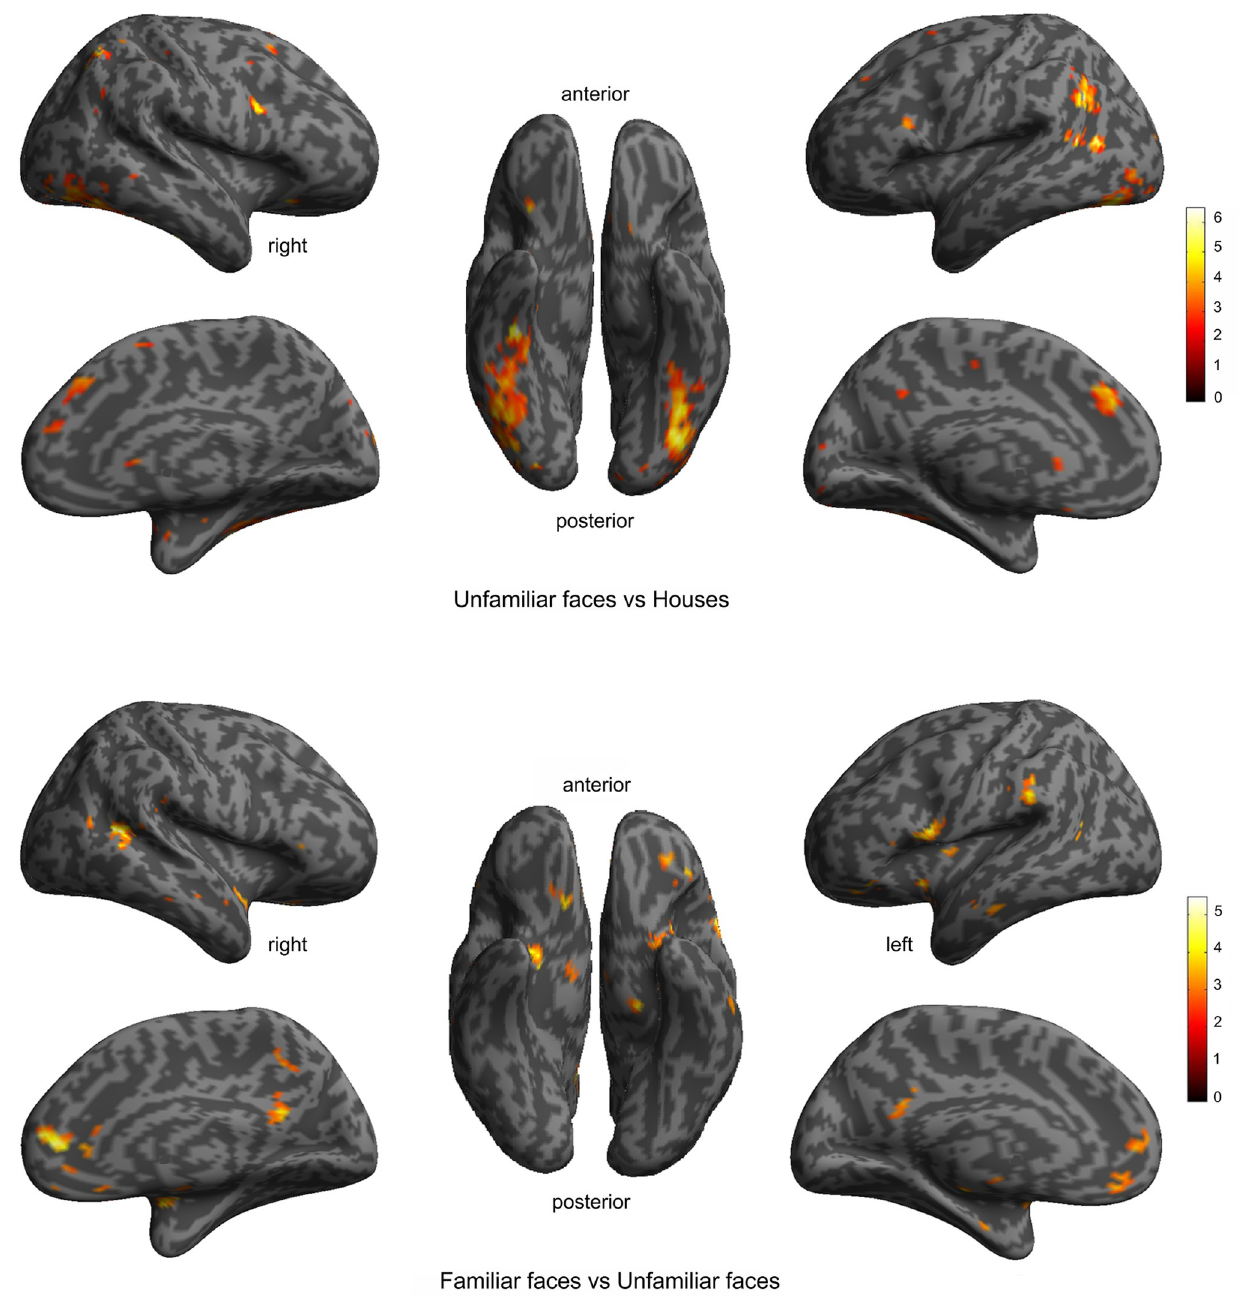
Fig 1. Functional activation identified by the contrasts: A) faces > houses and B) familiar faces > unknown faces. Maps were overlaid on the average inflated cortical surface of the SPM. The figure depicts voxels surviving p < 0.001 and p < 0.01 uncorrected, respectively. Color indicates the t-values.